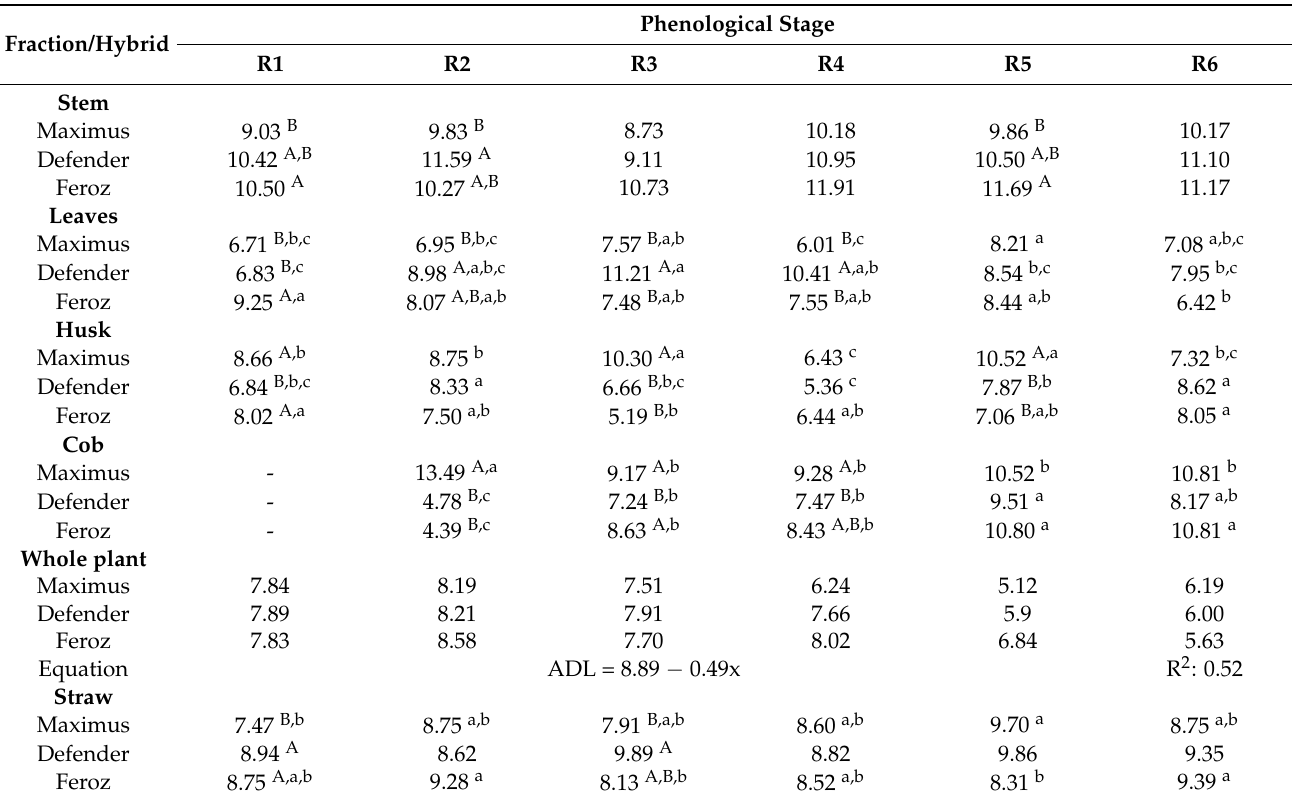
Table 5. Acid detergent lignin (% DM) of the whole plant and the fractions of three maize hybrids harvested at the beginning of the six reproductive stages of